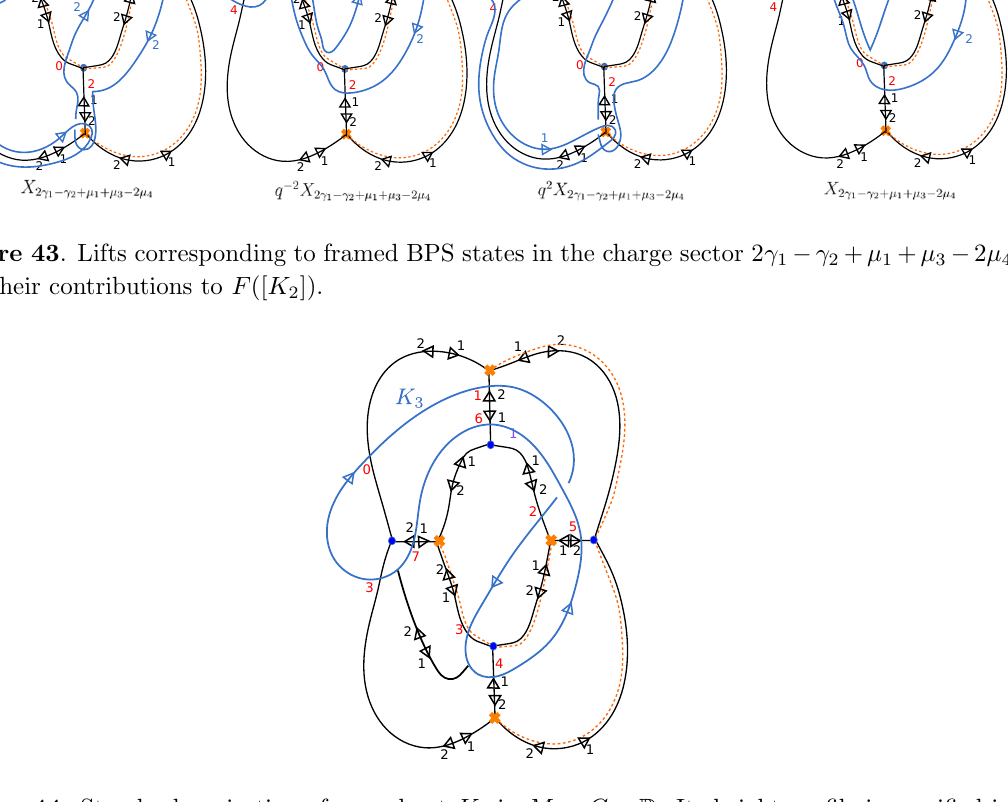
Figure 44 . Standard projection of an unknot K 3 in M = C (cid:2) R . Its height pro(cid:12)le is speci(cid:12)ed in the same convention as in (cid:12)gure